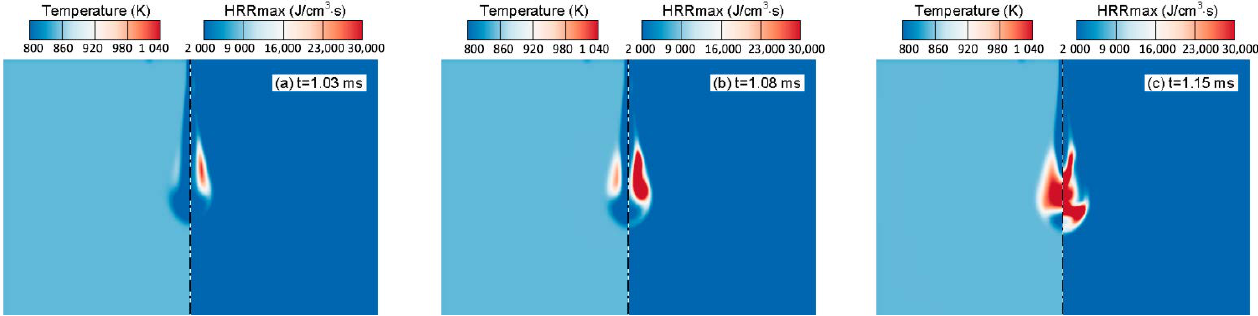
Figure 4. Temperature and exotherm distribution of n-heptane in CVB at an initial temperature of 850 K, an ambient oxygen concentration of 21%, a gas density of 14.8 kg/m 3 , and an injection pressure of 100 MPa.